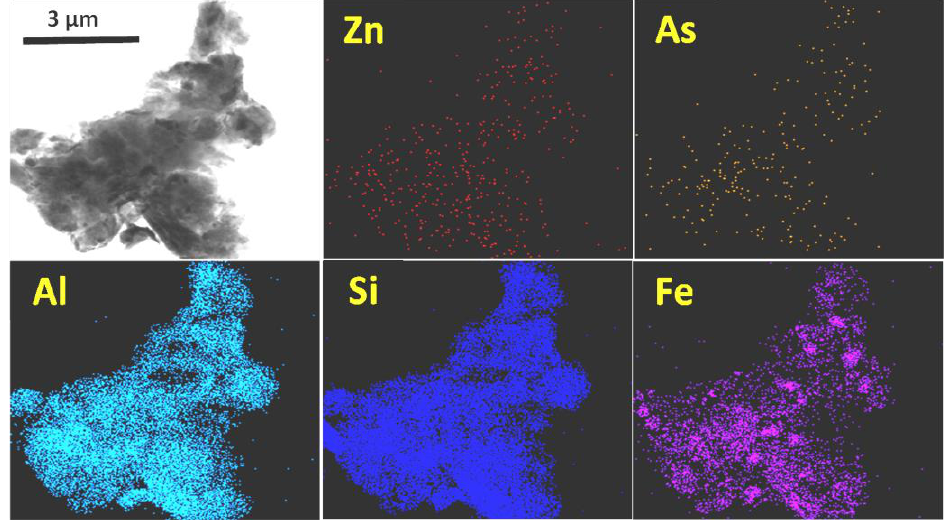
Figure 6. Zn, As, Al, Si and Fe distribution maps in a particle (first image) of a clay mineral.